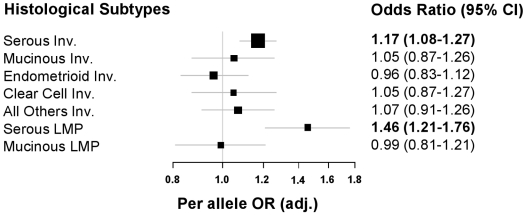
Histology-specific adjusted per allele risk estimates for rs7726159 for all ethnicities.Lines indicate 95% confidence intervals; bolded ORs and 95% CIs indicate statistically significant estimates (P<0.05); size of the solid box is the proportionate sample size for each histology sub-group with genotype data.